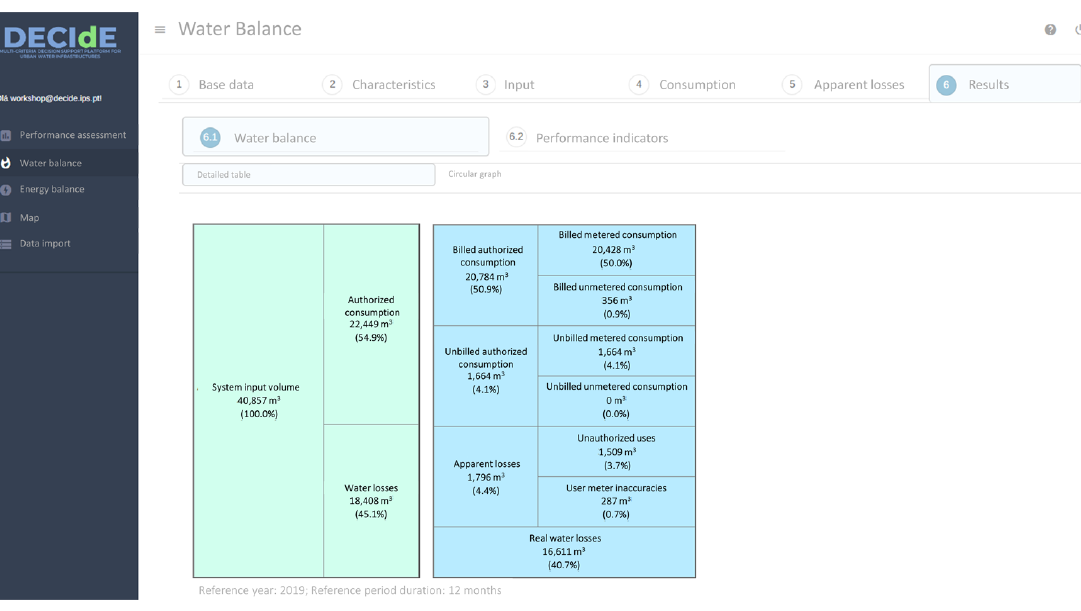
Figure 2. Screenshot of the window of the water balance in the DECIdE platform.